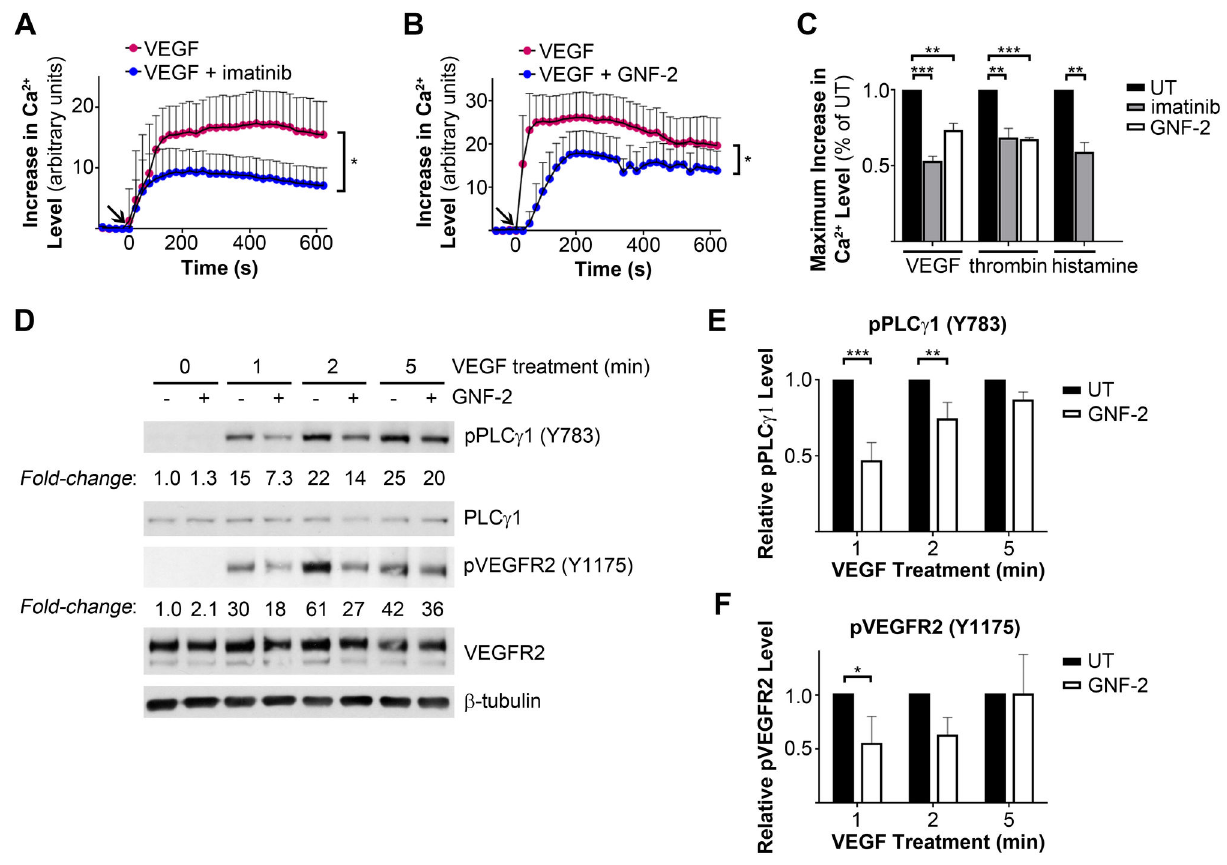
Figure 6. Abl kinase inhibition impaired Ca 2+ mobilization by endothelial permeability-inducing factors. ( A - B ) Quantification of intracellular Ca 2+ levels in HMVECs stimulated with VEGF (100ng/mL) with or without ( A ) imatinib (10μM) or ( B ) GNF-2 (15μM) pre-treatment. Values are expressed as increases in intracellular Ca 2+ levels, relative to levels in unstimulated cells. Arrows indicate timing of addition of permeability-inducing factors. Data are presented as means +/- SD of 35 cells per treatment and are representative of 3 independent experiments. ( C ) Quantification of inhibition of Ca 2+ mobilization by imatinib or GNF-2. Values shown are maximum intracellular Ca 2+ levels in HMVECs treated with VEGF, thrombin (1U/mL), or histamine (100µM) in the presence of Abl kinase inhibitors, relative to levels in vehicle-treated cells (UT). Data are presented as means +/- SEM (n=3). ( D ) Assessment of VEGF-mediated phosphorylation of PLCγ1 and VEGFR2 in HMVECs, with or without GNF-2 pre-treatment. ( E - F ) Quantification of levels of ( E ) phospho-PLCγ1 tyrosine (Y) 783 and ( F ) phospho-VEGFR2 Y1175 in HMVECs treated with VEGF +/- GNF-2, relative to levels in vehicle-treated cells (UT) at each time point. Data are presented as means +/- SD (n=3). *P<0.05; **P<0.01; ***P<0.001. doi: